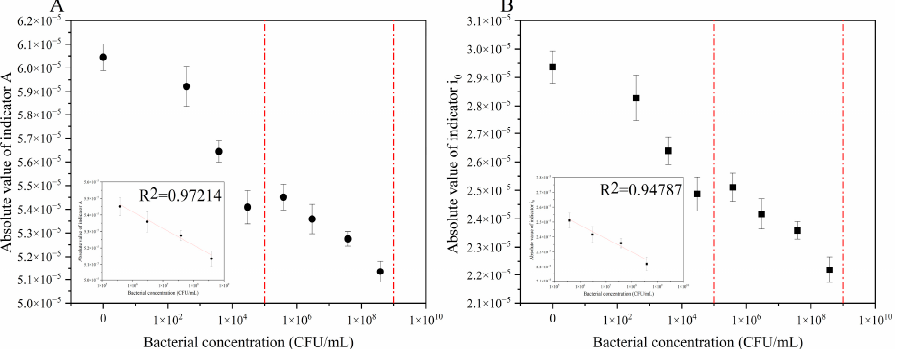
Figure 2. Electrochemical response of the same electrode system to different Escherichia coli concen- trations. ( A ) electric quantity index; ( B ) electric current index. These two detection indicators were inversely proportional to the concentration of E. coli .